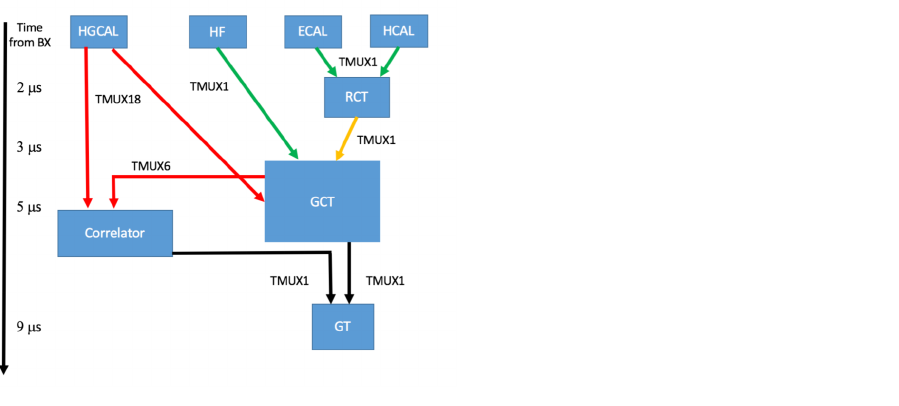
Figure 4. Calorimeter trigger architecture. It depicts the desired latency budget and time-multiplexing scheme employed for each calorimeter sub-system in Phase-2.